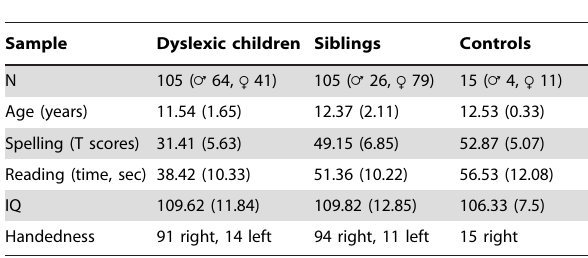
Table 1. Sample description, presenting the mean and standard deviation for sample number, age, spelling, reading, IQ, and